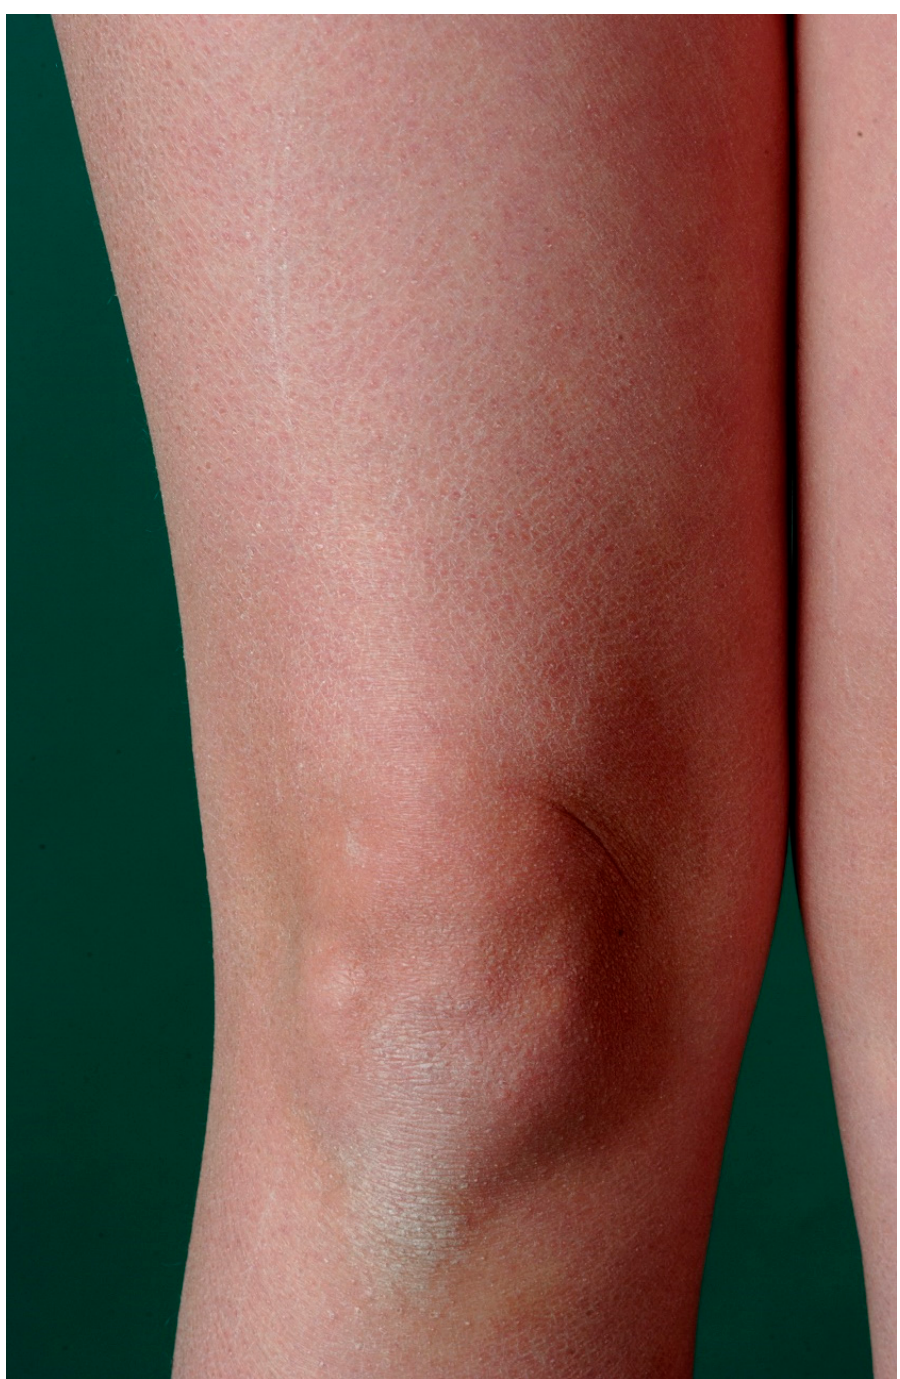
Figure 1. Ichthyosis vulgaris. Fine grey scaling on the extremities.